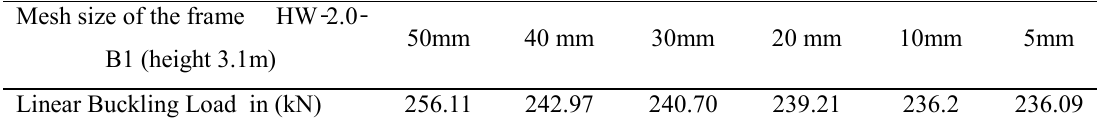
Results of the convergence study [12]. Mesh size of the